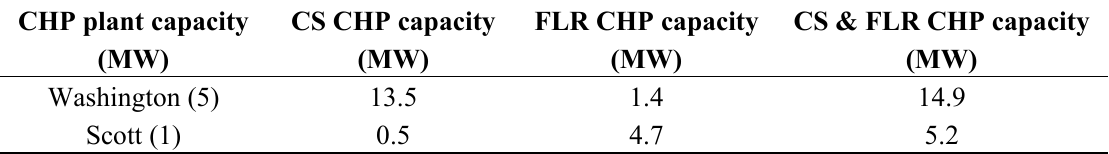
Table 4. Potential capacities of CHP plants in Washington and Scott based on higher utilization rates of corn stover and forest logging residue